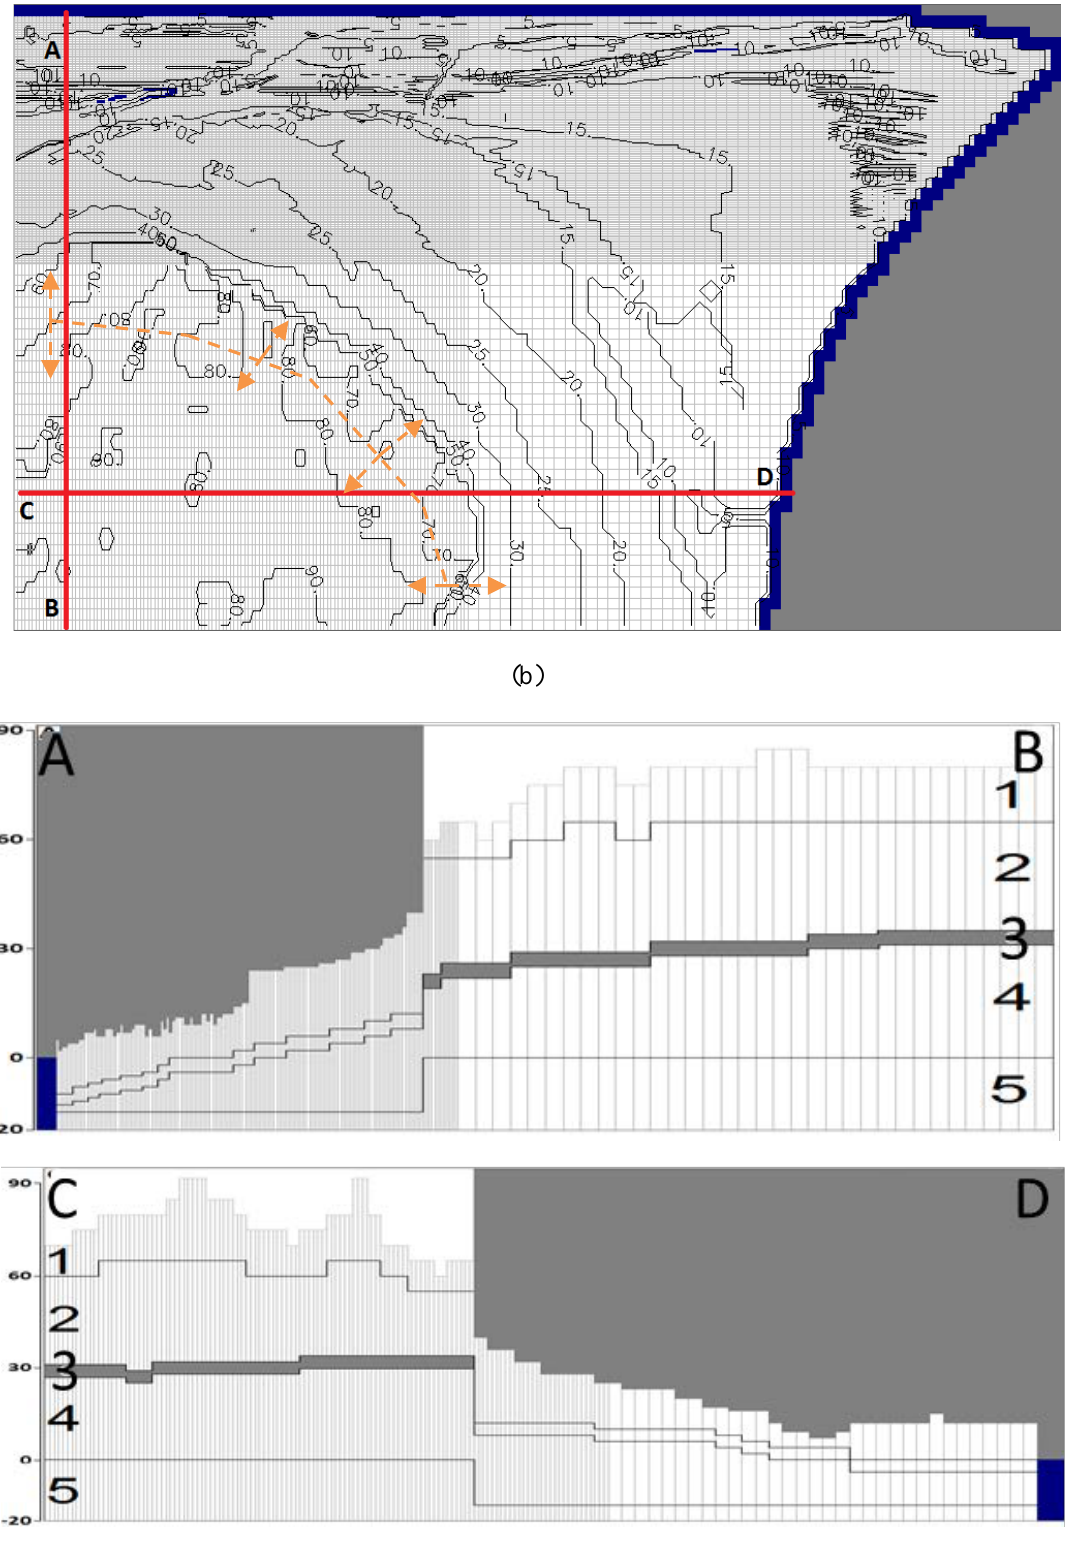
Figure 3. (a) Plan view of the model with contour lines representing the major topographic characteristics of the area, also the fault zone at the plateau. The dashed orange line marks the plateau area. The white and light grey boxes represent active cells; blue boxes represent cells with constant hydraulic heads, i.e. sea level. Finally, dark grey boxes represent inactive cells, where no flow can take place. (b) South [B] to north [A] cross-section showing the main characteristics of the model, and (c) west [C] to east [D]